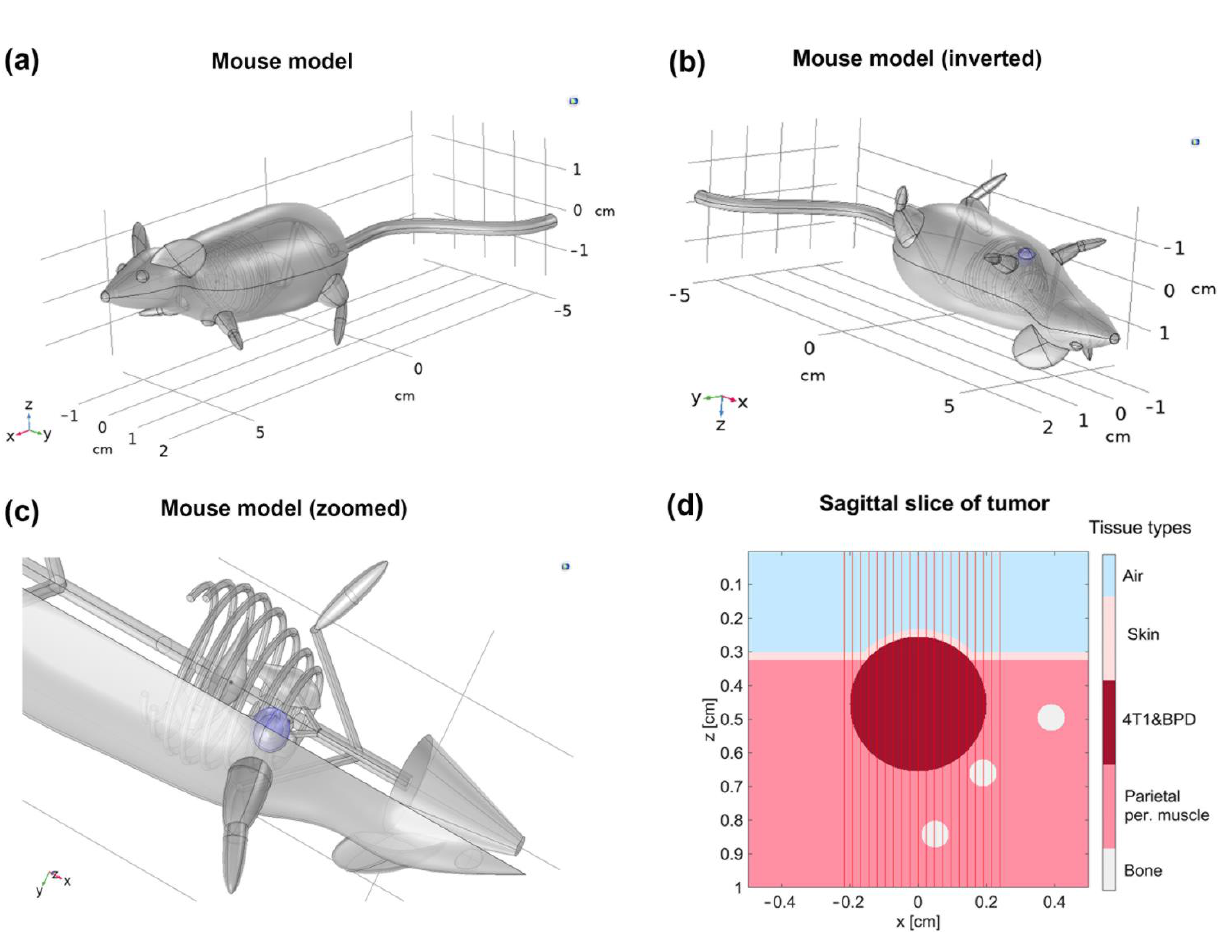
Figure 1. ( a , b ) The mouse model in two different orientations and ( c ) zoomed area of the mouse model, as implemented in COMSOL Multiphysics ® . ( d ) Sagittal slice of the tumor area, created in MATLAB. The three white dots correspond to nearby ribs, while the vertical red lines are a visual representation of the incident laser beam.